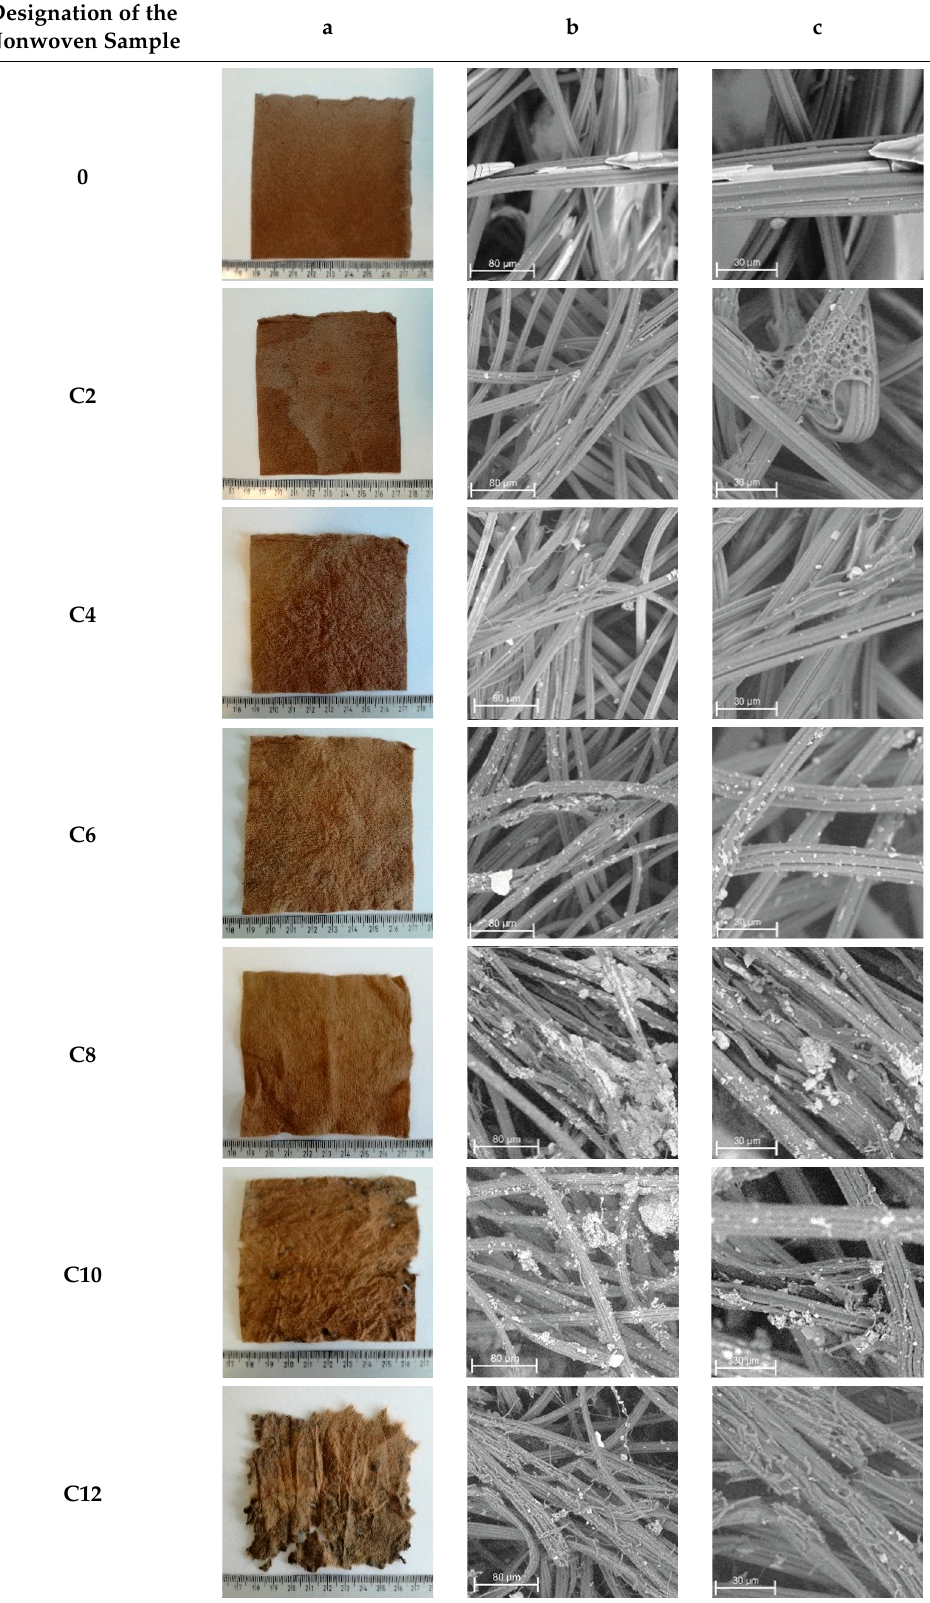
Table 3. The process of nonwoven C biodegradation observed in photographs (a) and SEM micro- graphs: at a magnification of 1000 × (b), and a magnification of 2500 × (c). The numbers next to the nonwoven C indicate the weeks of testing.